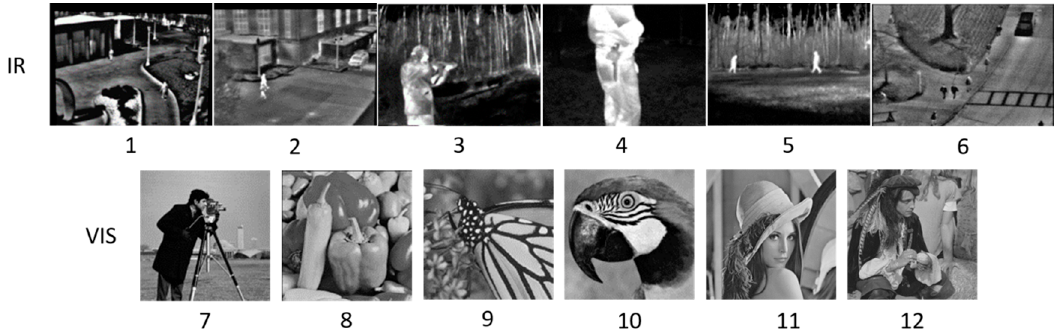
Figure 6. The 12 IR and VIS images used for performance evaluation.